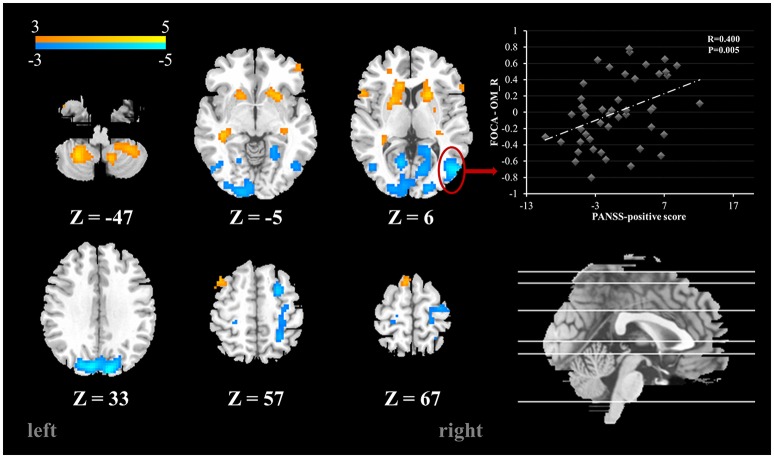
Brain areas with significant FOCA value differences between groups (p < 0.05, FDR corrected). Color bar represents t-values. Scatter plots depicting the significant positive correlations relationship between the residual of regional FOCA in the right MOG (functional properties that were regressed using controlling variables) and the residual of PANSS positive score (PANSS positive score that were regressed using controlling variables).